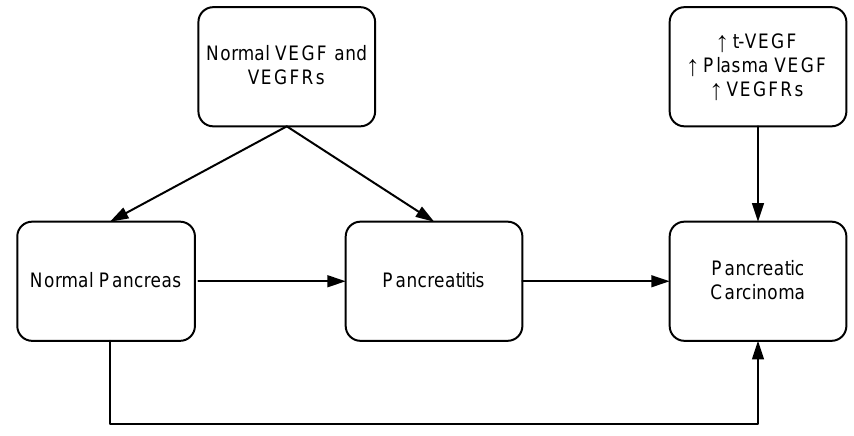
Figure 3. Variable expression of VEGF and VEGFRs in normal pancreas, pancreatitis and pancreatic carcinoma.